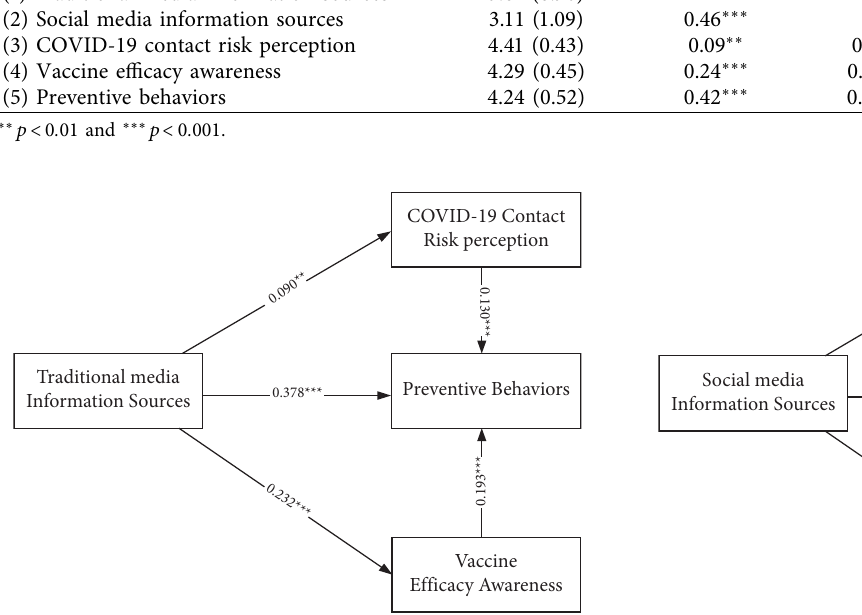
Figure 1: Te multivariate regression models of traditional media information sources on preventive behaviors. ∗∗ p < 0 . 01 and ∗∗∗ p < 0 . 001.